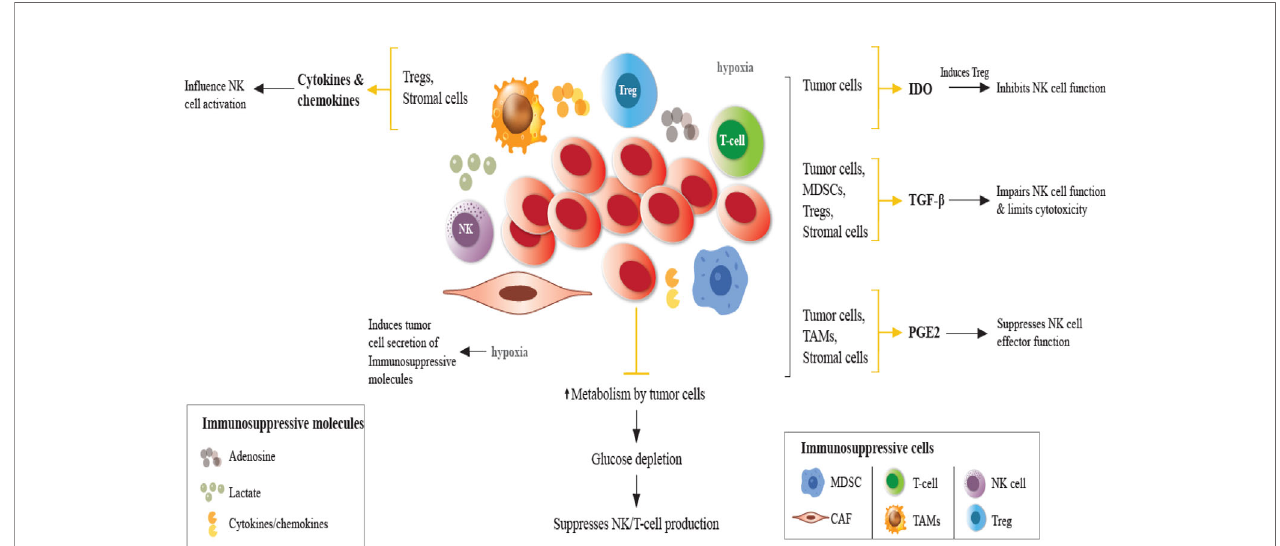
FIGURE 1 | Impaired NK cell function in the TME. In the TME, immunosuppressive cells and molecules, in the presence of hypoxia and glucose depletion negatively regulate the maturation, proliferation, activation, and effector function of NK cells. Hypoxia induces tumor cells to secrete immunosuppressive molecules, such as TGF- b , IL-10, VEGF, galectins, and CC-chemokine ligands, contributing to the accumulation of TAMs, Tregs, MDSCs, which suppress DCs, T and NK cells. Under hypoxic conditions, NK cells fail to upregulate the expression of activating receptors. Cytokines/chemokines produced by Tregs and stromal cells in fl uence NK cell activity. Tumor cells directly exert immunosuppressive effects on NK cells through the secretion of soluble factors. TGF- b production by tumor cells, Tregs, MDSCs, and other stromal cells impairs NK cell function. IDO induces Treg which inhibits NK cell function. IDO expression induces growth arrest of NK cells and promotes tumor progression. PGE2 production in the TME suppresses the effector function of NK cells. Adenosine secretion by tumor cells and lactate accumulation reduces NK cell cytotoxicity promoting immunosuppression by MDSCs, Tregs and TAMs. TGF- b , transforming growth factor- b ; PGE2, prostaglandin E2; IDO, indoleamine 2,3 dioxygenase; NKG2D, natural killer group 2D; MDSCs, myeloid-derived suppressor cells; Tregs, regulatory T cells (Tregs); TAMs, tumor-associated